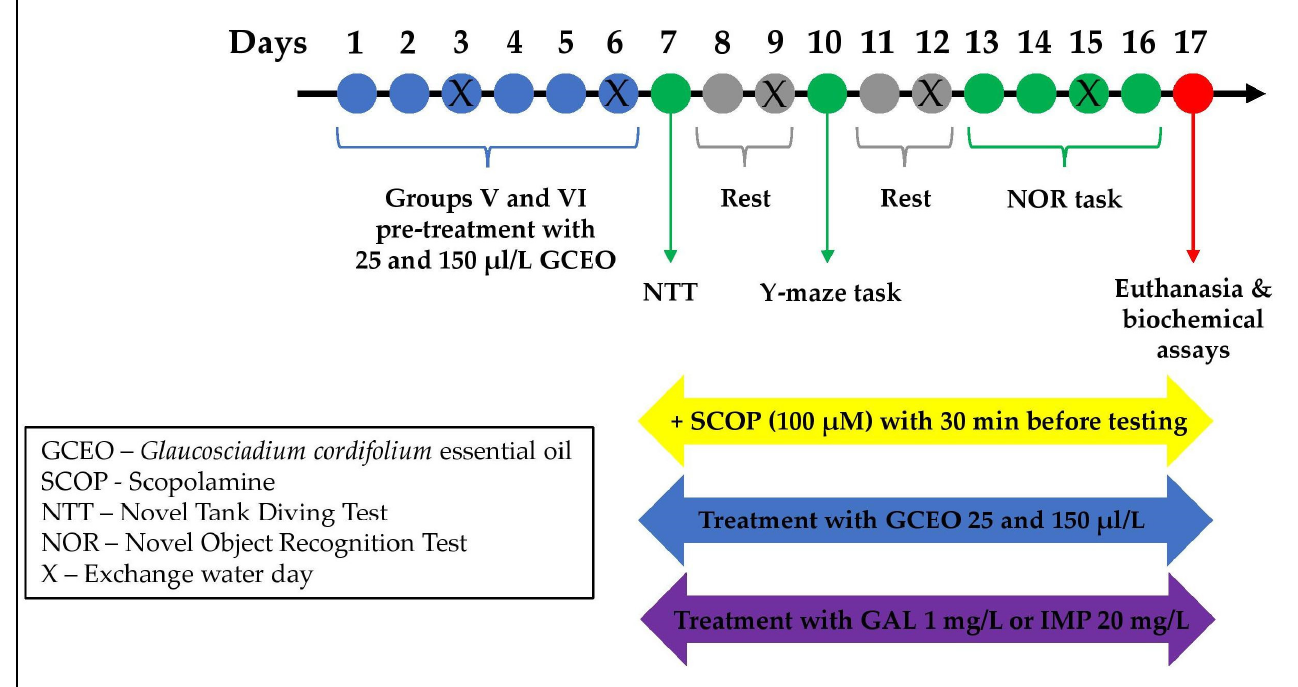
Figure 7. The experimental design of the study.